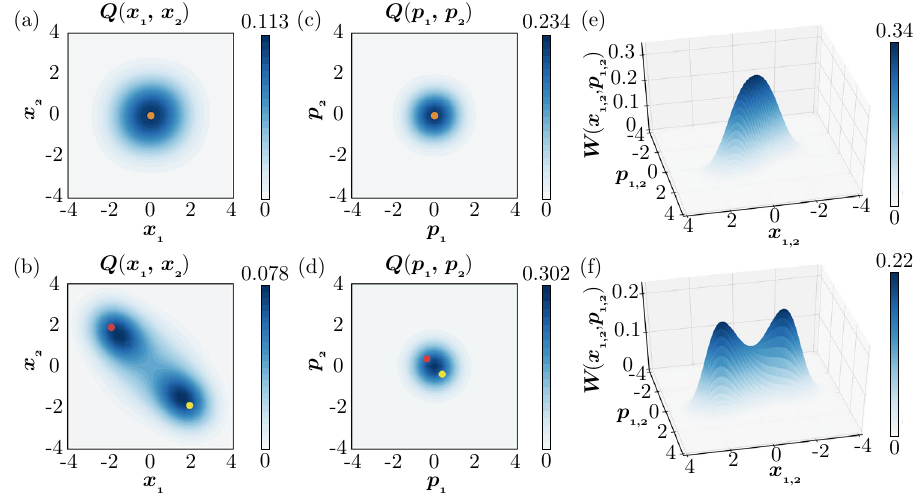
Figure 3. Turing instability in a pair of diffusively coupled quantum activator–inhibitor units in the semiclassical regime. ( a , b ) 2D plots of the Q distribution Q ( x 1 , x 2 ) . ( c , d ) 2D plots of the Q distribution Q ( p 1 , p 2 ) . ( e , f ) 3D plots of the stationary Wigner distributions W ( x 1 , p 1 ) and W ( x 2 , p 2 ) of the units 1 and 2. Red and yellow dots in ( a – d ) represent stable fixed points of the deterministic system in the classical limit. In ( a , c , e ), the two units are uncoupled. The states of the units are uncorrelated and localized around the origin; hence, the whole system is in a uniform state. In ( b , d , f ), the two units are diffusively coupled. Due to the Turing instability, the two units tend to take different states from each other; hence, the whole system is nonuniform. In ( e , f ), the Wigner distributions for the units 1 and 2 are identical to each other and hence shown as a single plot. The 0.3 . 0.6, γ 1 0.4, γ 2 0.1, θ π , and η parameters of the quantum activator–inhibitor units are � = = − = = = 0 ) in ( a , c , e ) and D 0.005 and D 0 ( D 0.995 0 and D D p The diffusion constants are D x c = x = p = h = = = 1 ) in ( b , d , f 0.99 and D ( D h c = = −